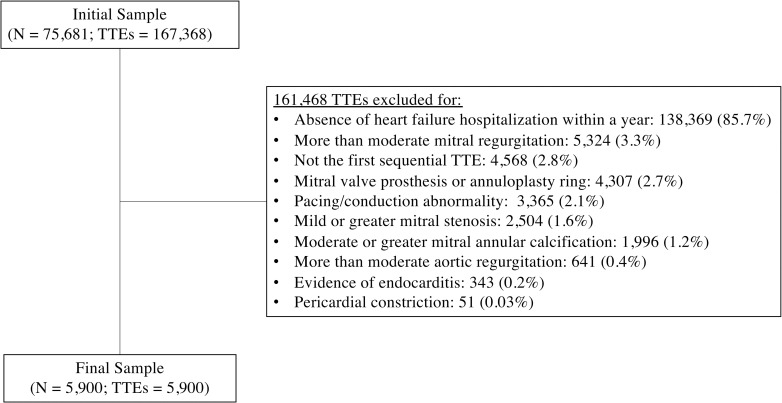
Flow diagram of patients included in study.TTEs = transthoracic echocardiograms.